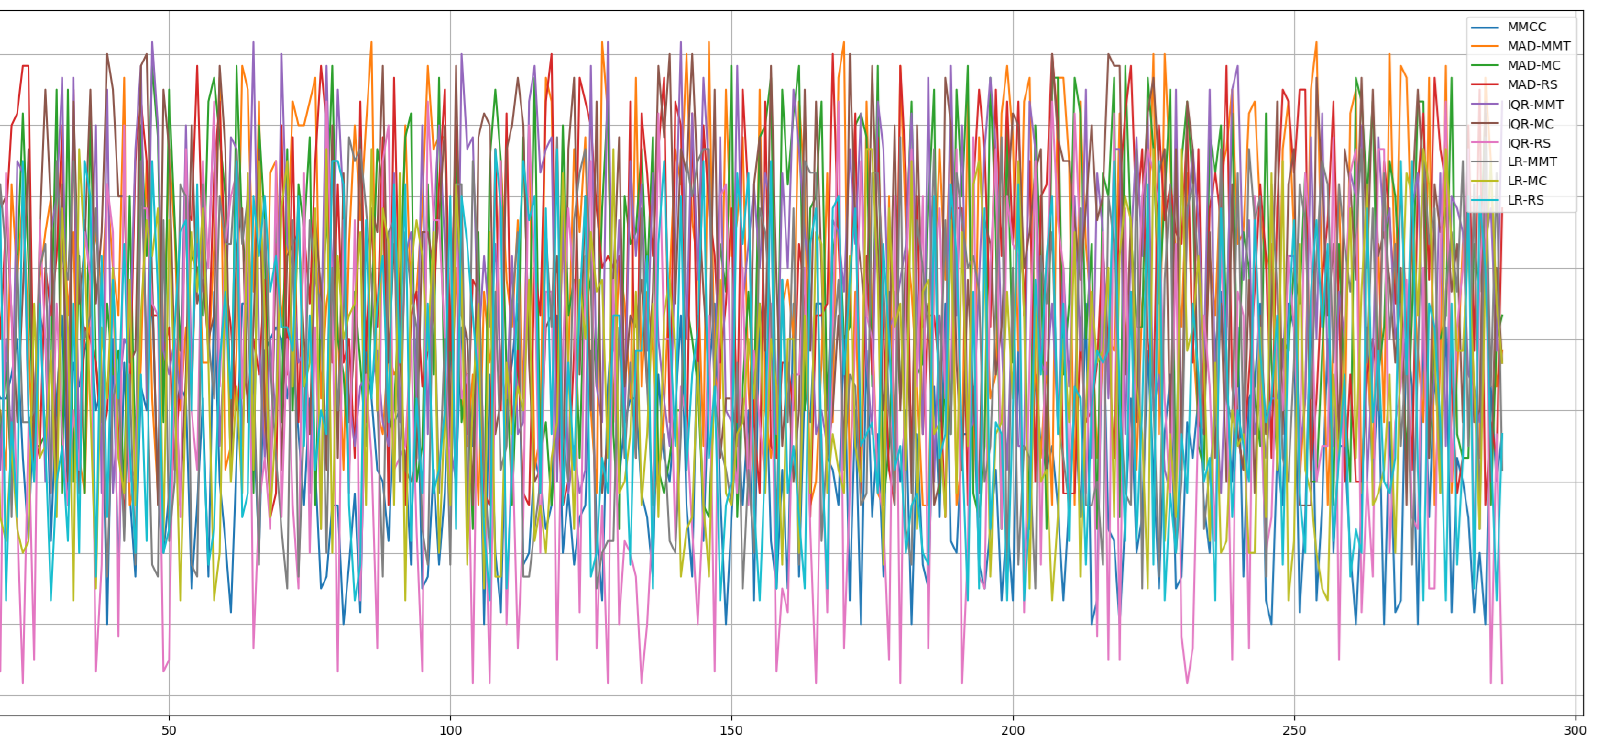
Figure 12. Comparing the number of VM migrations triggered by all methods in every time